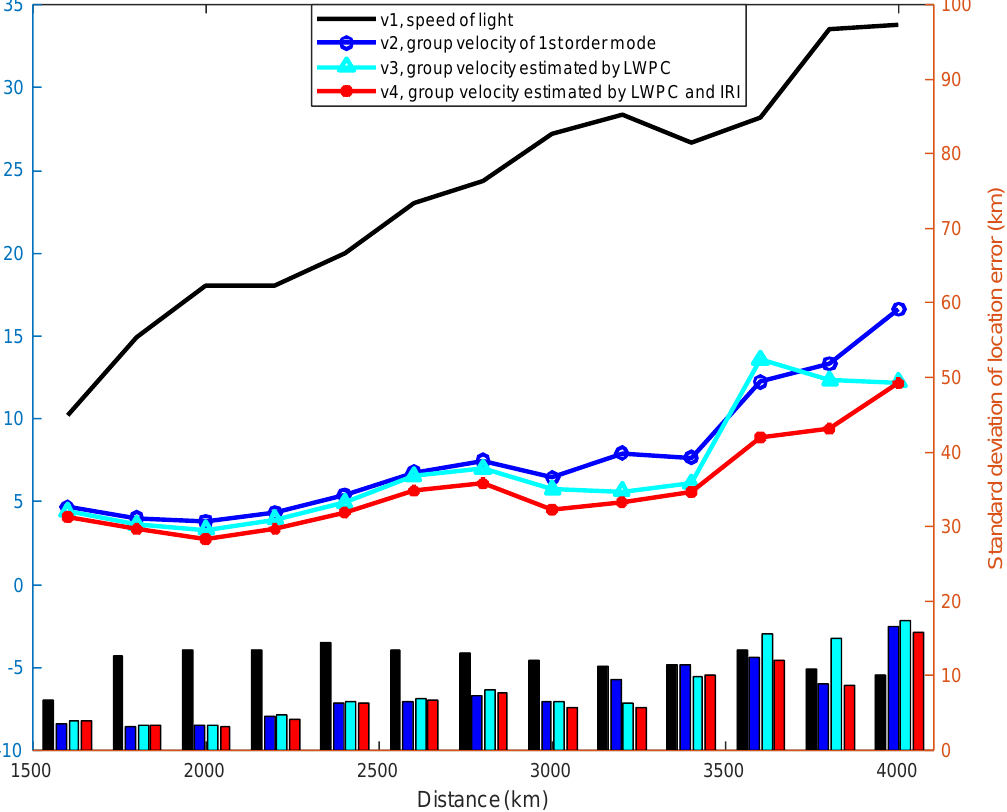
Figure 7. The relationship of lighting location errors with the distance from lightning events to ELLN. The comparison is made among different methods of group velocity estimation using lightning location results in the daytime. The curves are the mean values, and the bar graphs are the standard deviations, which correspond to the left and right y-axes respectively.